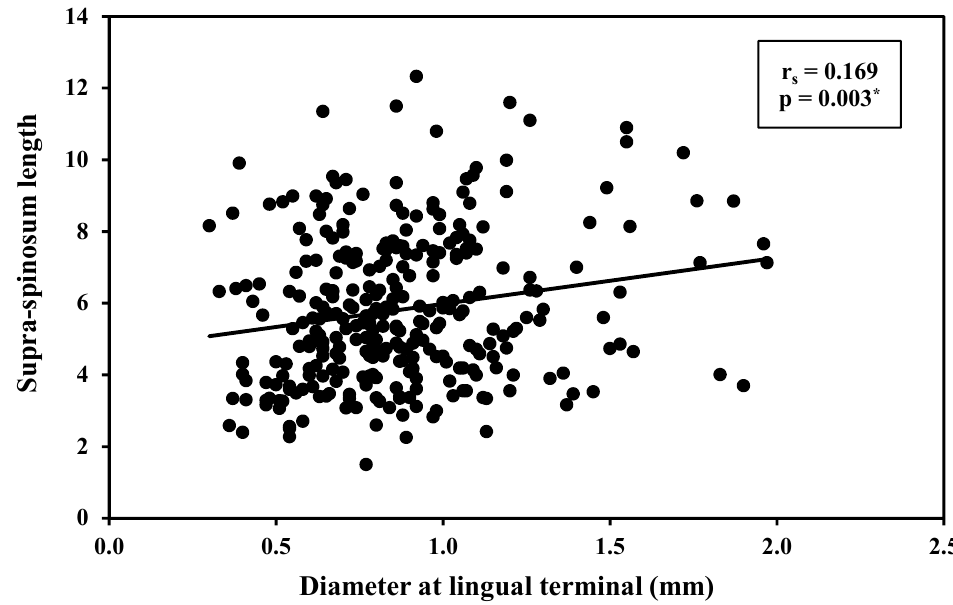
Figure 4. Correlation between supra-spinosum canal length and its diameter at the lingual terminal (mm). r s : Spearman coefficient; *: statistically significant at p ≤ 0.05. Table 5. Correlation between length (mm) vs. diameter at the lingual terminal (mm) for supra-inter and infra spinosum canals.